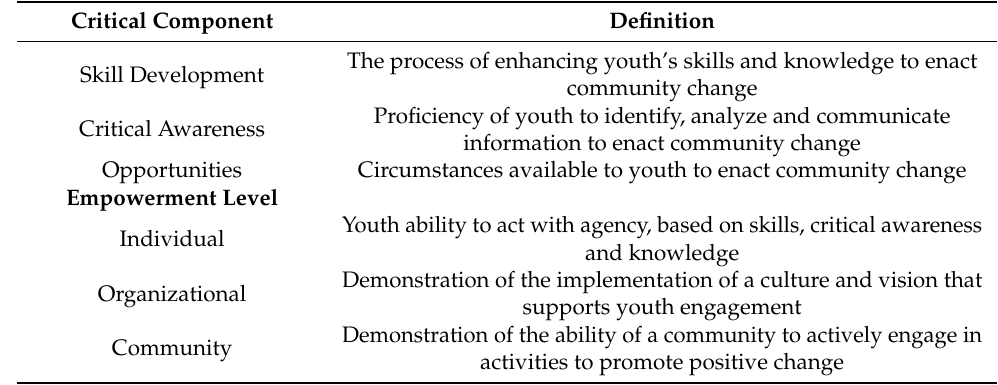
Table 1. Youth Empowerment Solutions (YES!) Youth Empowerment Model: Critical Components, Empowerment Levels, and Definitions